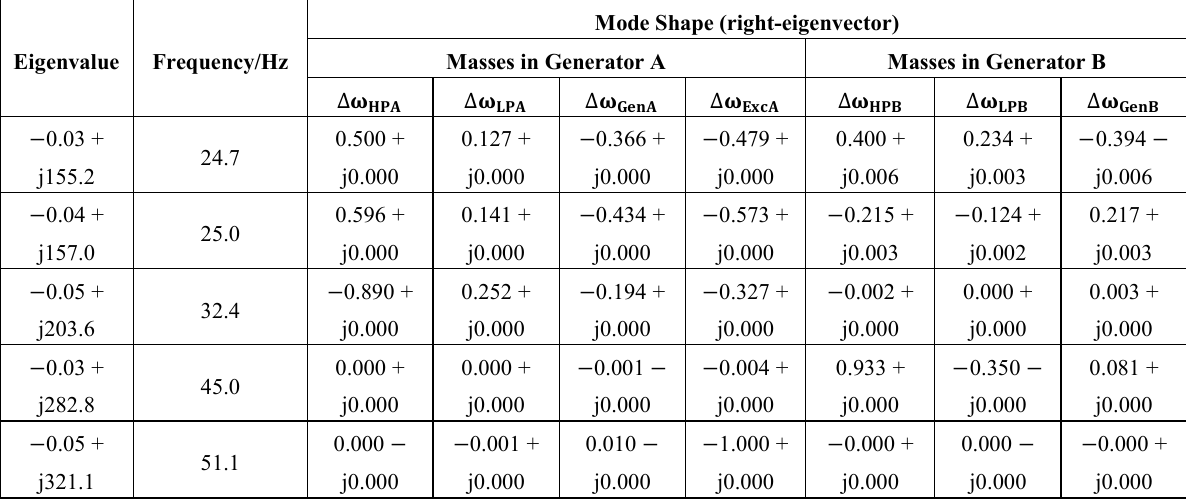
Table 4. Eigenvalue result of the equivalent double-generator